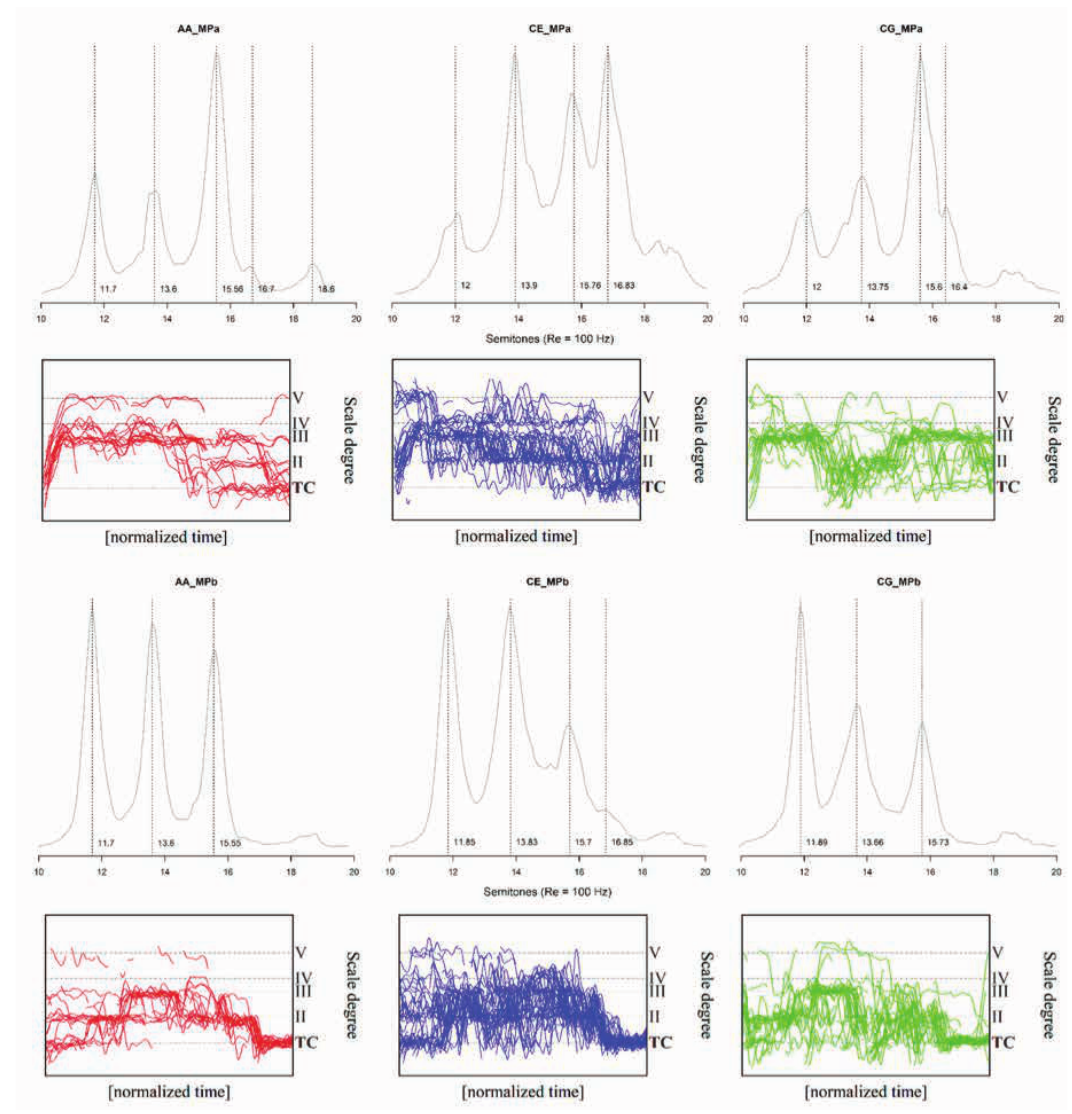
Figure 6: Histograms of frequency and, below, corresponding pitch profiles, divided per poet (AA, CE and CG) and melodic phrase (MPa and MPb). The y-axis graph of the pitch profiles indicates the tonal center (TC) and the scale degree of the major scale (i.e., with reference to the TC: II = +2 st, III = +4 st, IV = +5 st, V = +7